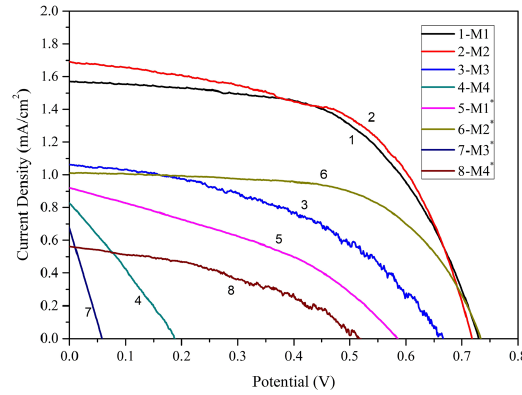
dependence on the Anatase OC